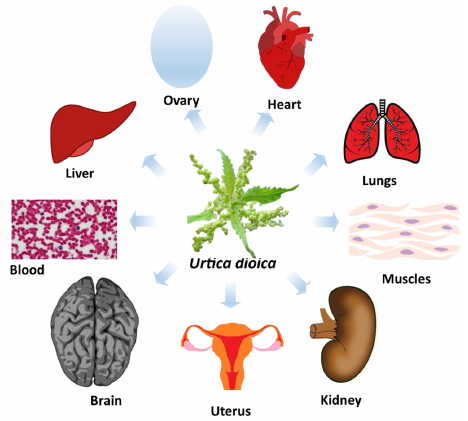
Figure 1. Antioxidant activity of UD observed in different organs. 3.1. In Vitro Antioxidant Studies In an initial study to analyze the antioxidant activity of twenty-seven non-cultivated